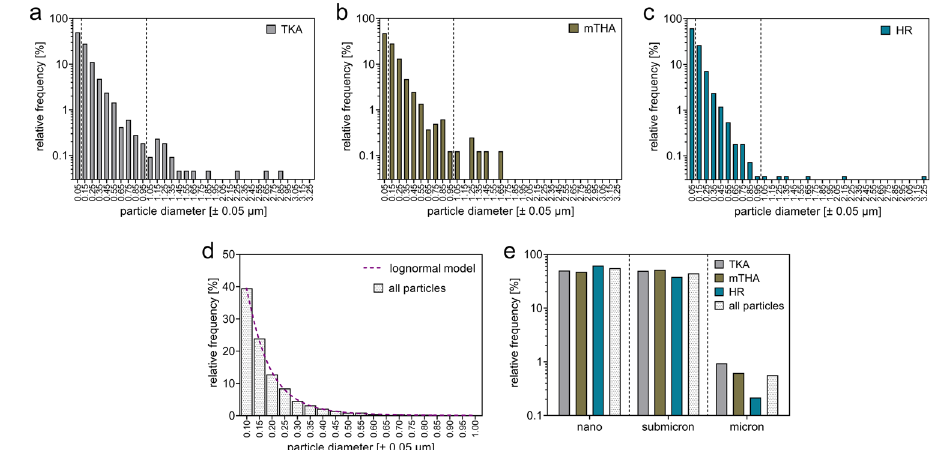
Fig. 4 Size frequency evaluation of particles from three different implant types revealed distribution pattern towards more frequent occurrence of particles in the nano- and submicron-scale. a – c Particle size distribution in periprosthetic bone marrow samples proximate to total knee arthroplasty implants (TKA), modular total hip arthroplasty